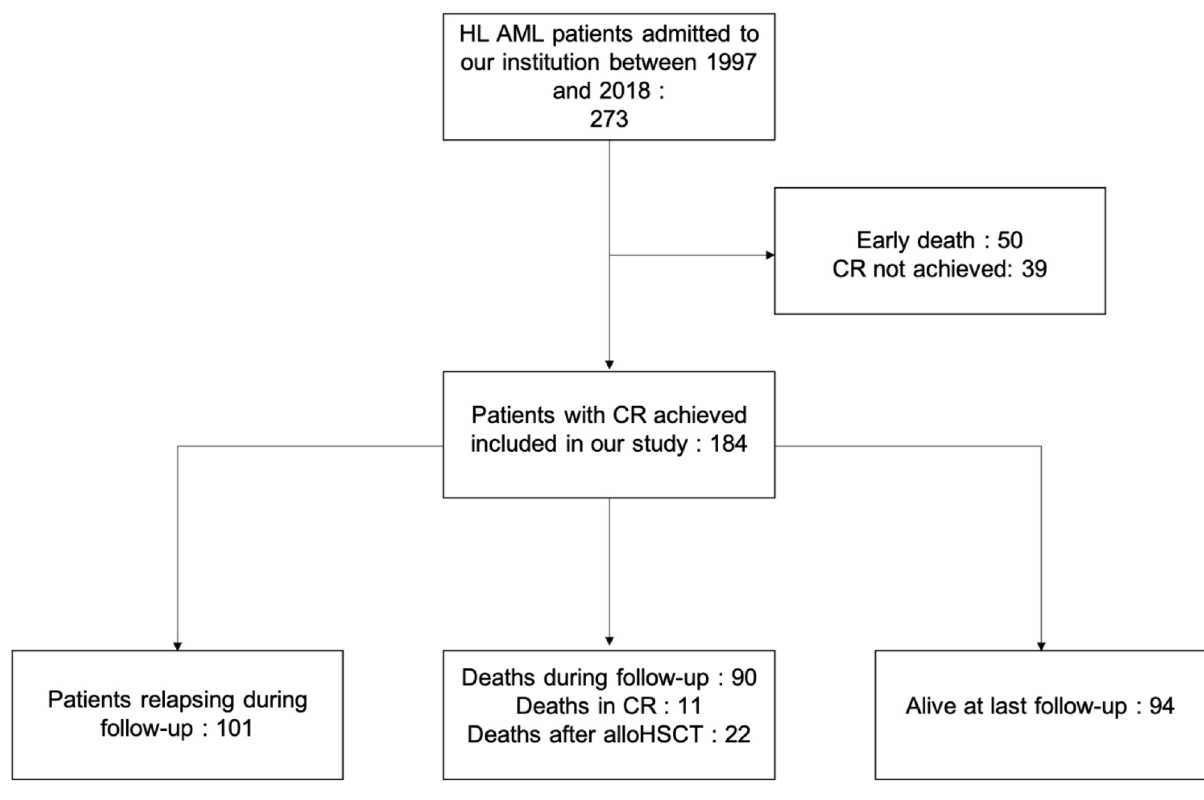
Fig 1. Flow chart of patients study